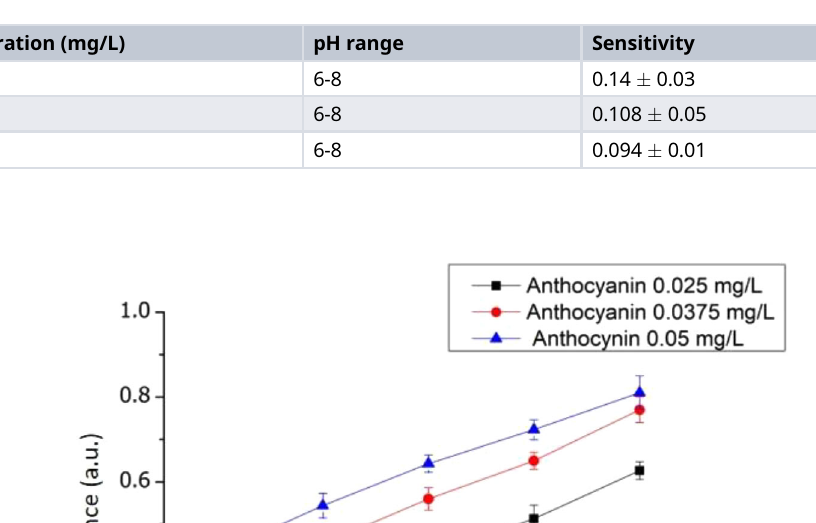
Table 1. Effect of ACN concentrations on the sensitivity of the optical pH sensors on phosphate buffer.